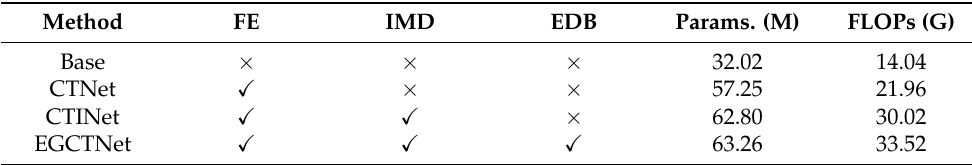
Table 4. Params and FLOPs of ablation experiments model.